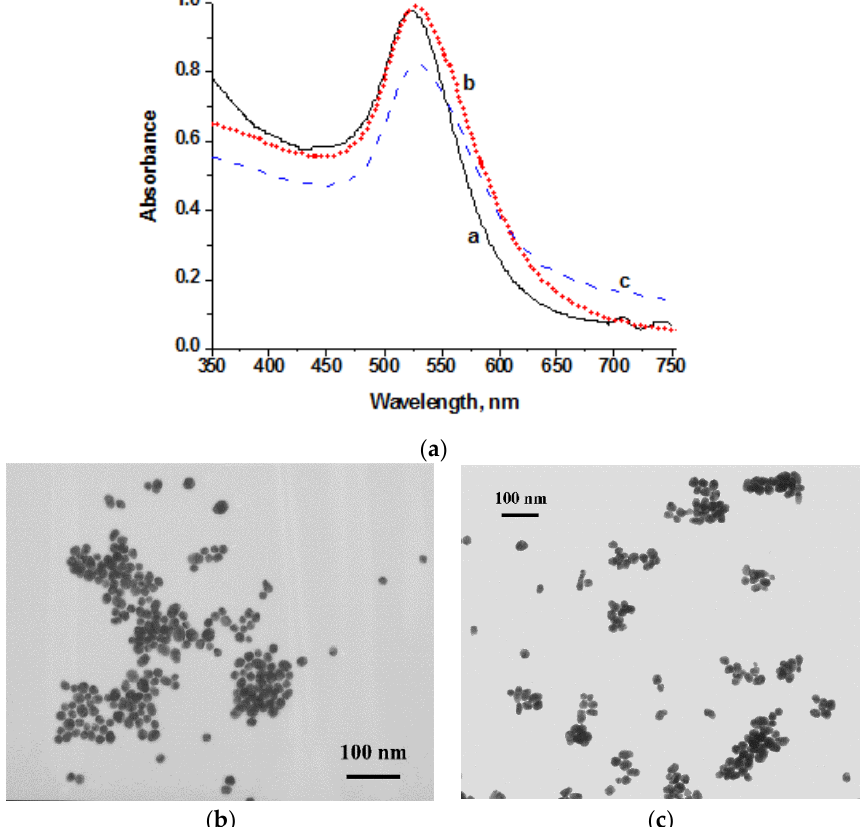
Figure 2. ( a ): UV–vis spectra of AuNPs of 30 nm ( a ) and 40 nm ( b ) diameter, and AuNPs functionalized with 4-mercaptobenzoic acid (4-MBA) and coupled with anti-lincomycin (LIN) monoclonal antibodies (AuNPs–MBA–Ab) ( c ); ( b ) microphotograph of AuNPs for colorimetric LFIA. The average diameter is 29.5 ± 7.4 nm and the degree of polydispersity is 1.3; ( c ) microphotograph of AuNP–MBA for SERS-based LFIA. The average diameter is 39.5 ± 5.0 nm and the degree of polydispersity is 1.3.